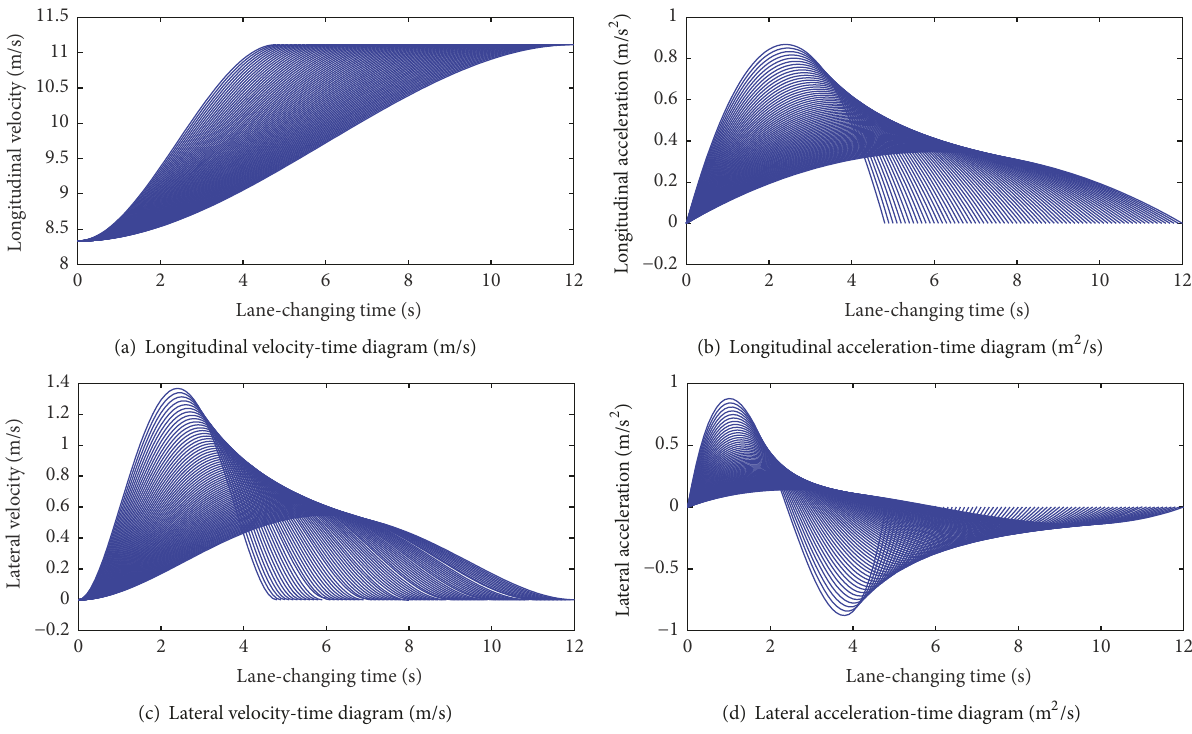
Figure 7: Velocity and acceleration diagrams of the host vehicle ( 𝑀